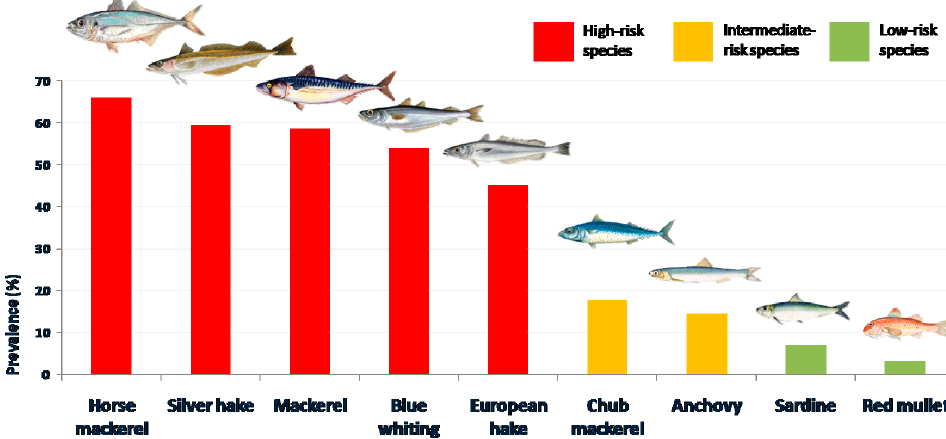
Figure 1. Classification of the fish species based on the prevalence (%) of Anisakis type I larvae.